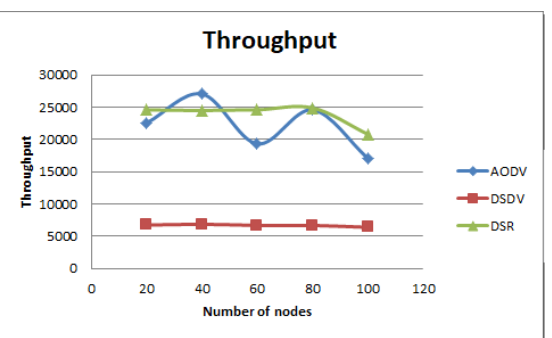
Table 4:- Average End to end delay